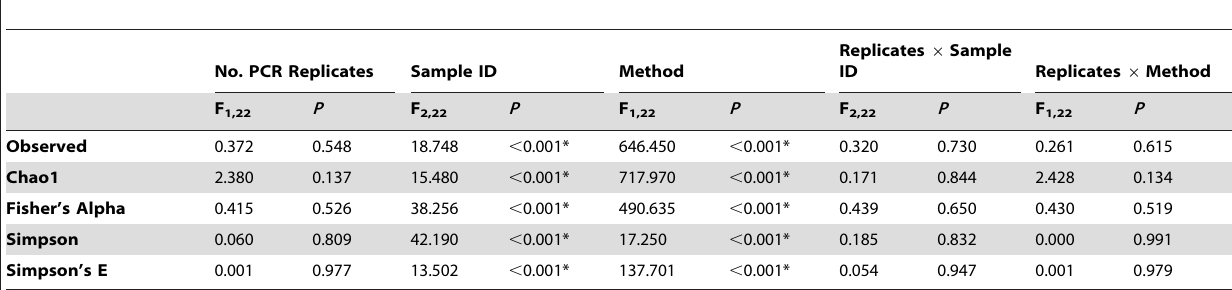
Table 1 . Analysis of variance tests for an effect of PCR replicate number, sample identity, and sequencing method on fungal richness from the CT2, OR1, and OR4